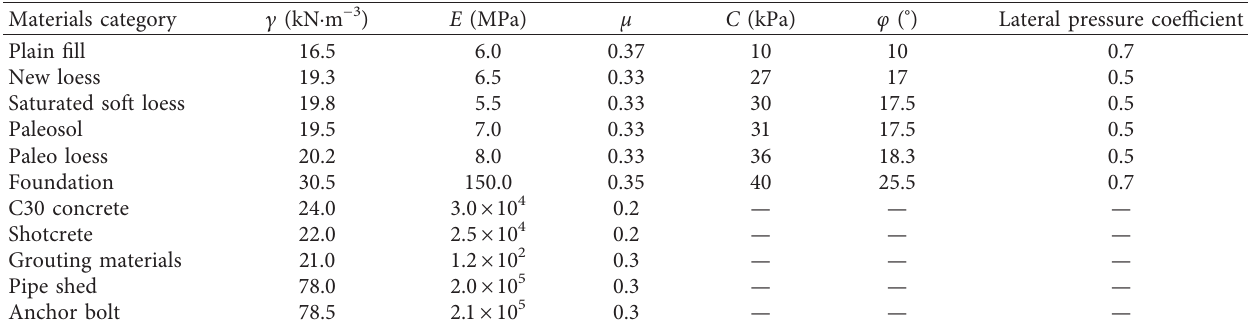
Table 5: Physical and mechanical